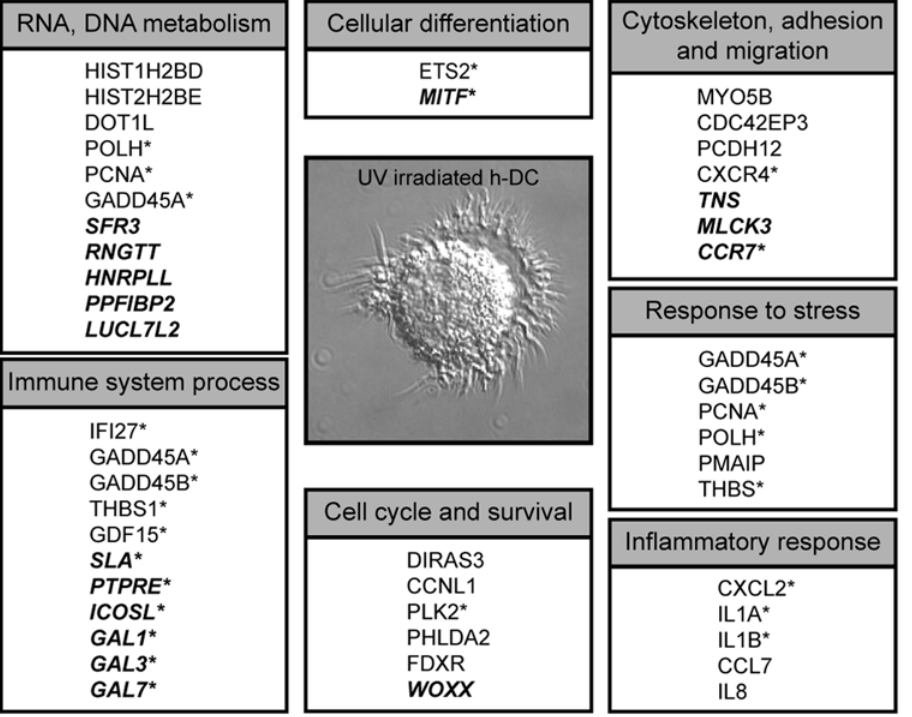
Figure 4. Summary of Genes modified on DCs by Solar-Simulated irradiation. Genes down-regulated or up-regulated in UV irradiated human DCs, compared to non-irradiated DCs were grouped by functional groups, using Gene Ontology designations (WebGestalt) and published literature. Genes bold and italic correspond to down-regulated-genes. (*) Genes selected to corroborate by PCR.